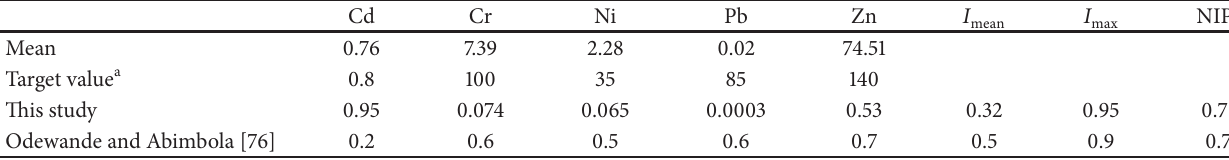
Odewande and Abimbola [76]